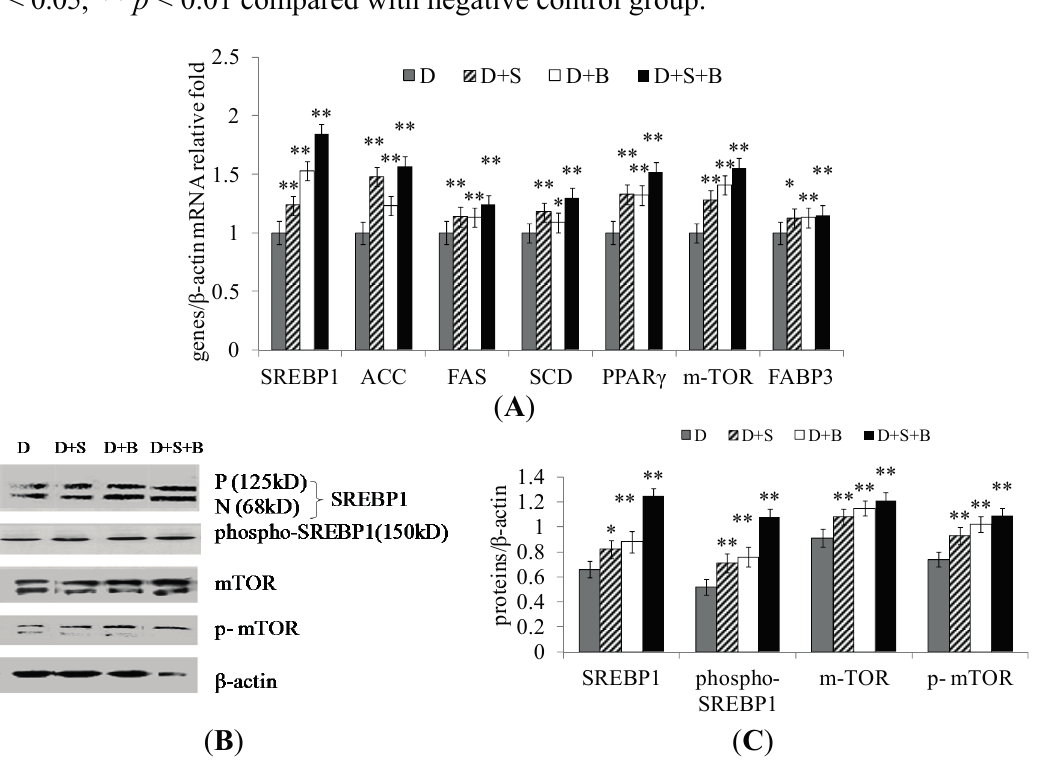
Figure 4. The effect of stearic acid and serum on the regulation of milk fat synthesis by SREBP1. Four groups of DCMECs were assessed: Untreated cells grown in DF12 media (control group, D), DCMECs treated with stearic acid (0.1 mM) + DF12 (D + S), DCMECs treated with DF12 and 10% FBS (D + B), and DCMECs treated with stearic